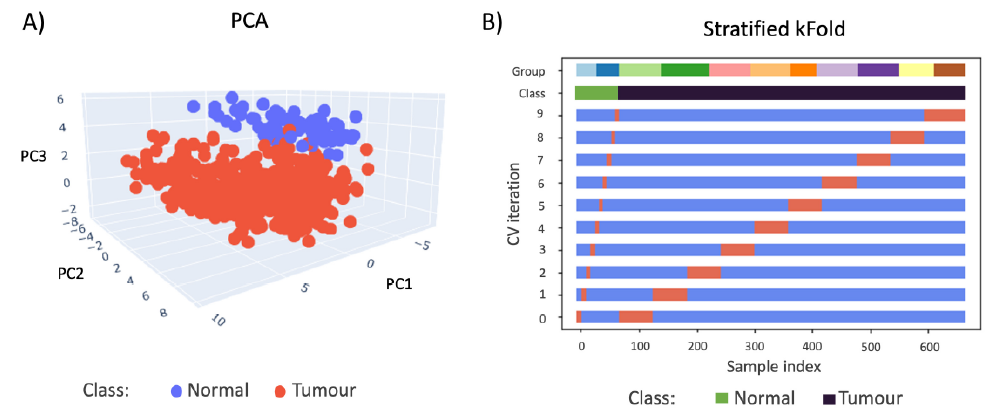
Figure 5. ( A ) 3D PCA plot (first 3 components) visualisation of normal (blue) and cancer (red) FFPE core MSI data. PC1 = 34.60%, PC2 = 25.97%, and PC3 = 7.90% ( B ) The cross-validation behaviour is visualised and colour-coded to display the imbalance in distribution. The group colour codes show the number of samples in each TMA. The data was split 10 times, and the samples chosen for training (blue) and testing (orange) are clearly indicated for each iteration of